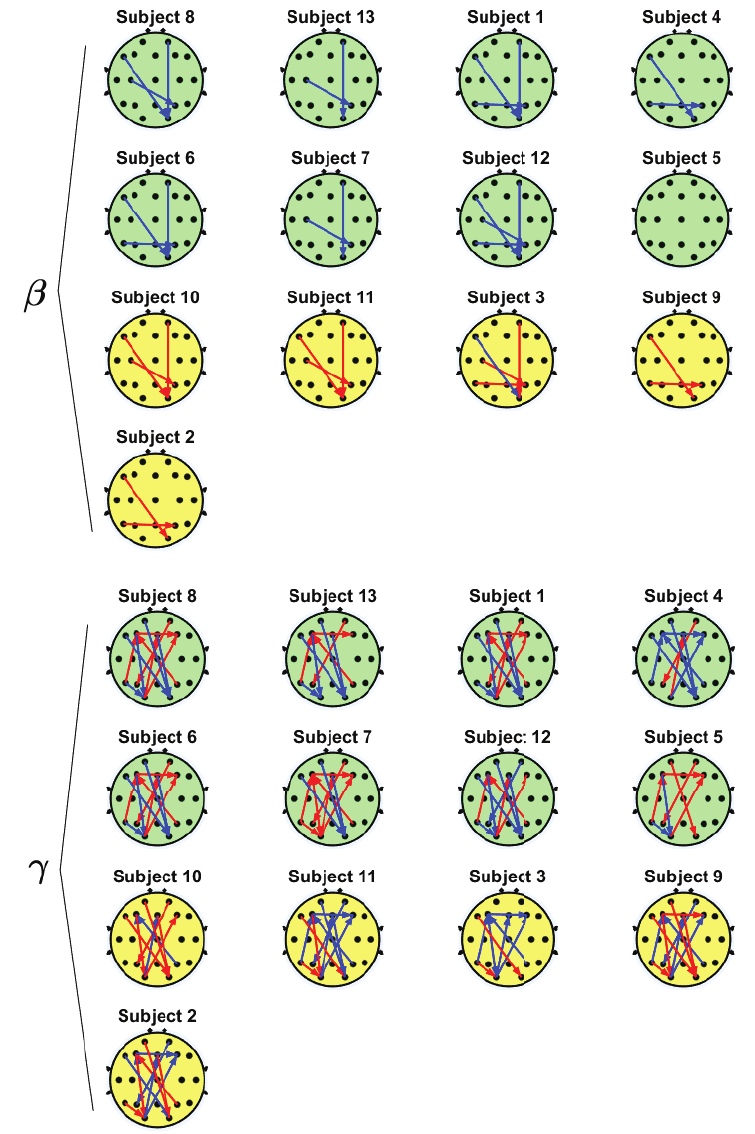
Figure 3. Representative PDC interactions for SOs (green) and NSOs (yellow) in the beta ( top ) and gamma ( bottom ) bands. Red and blue arrows correspond to incremental and decremental interactions (i.e, functional connectivity over time),